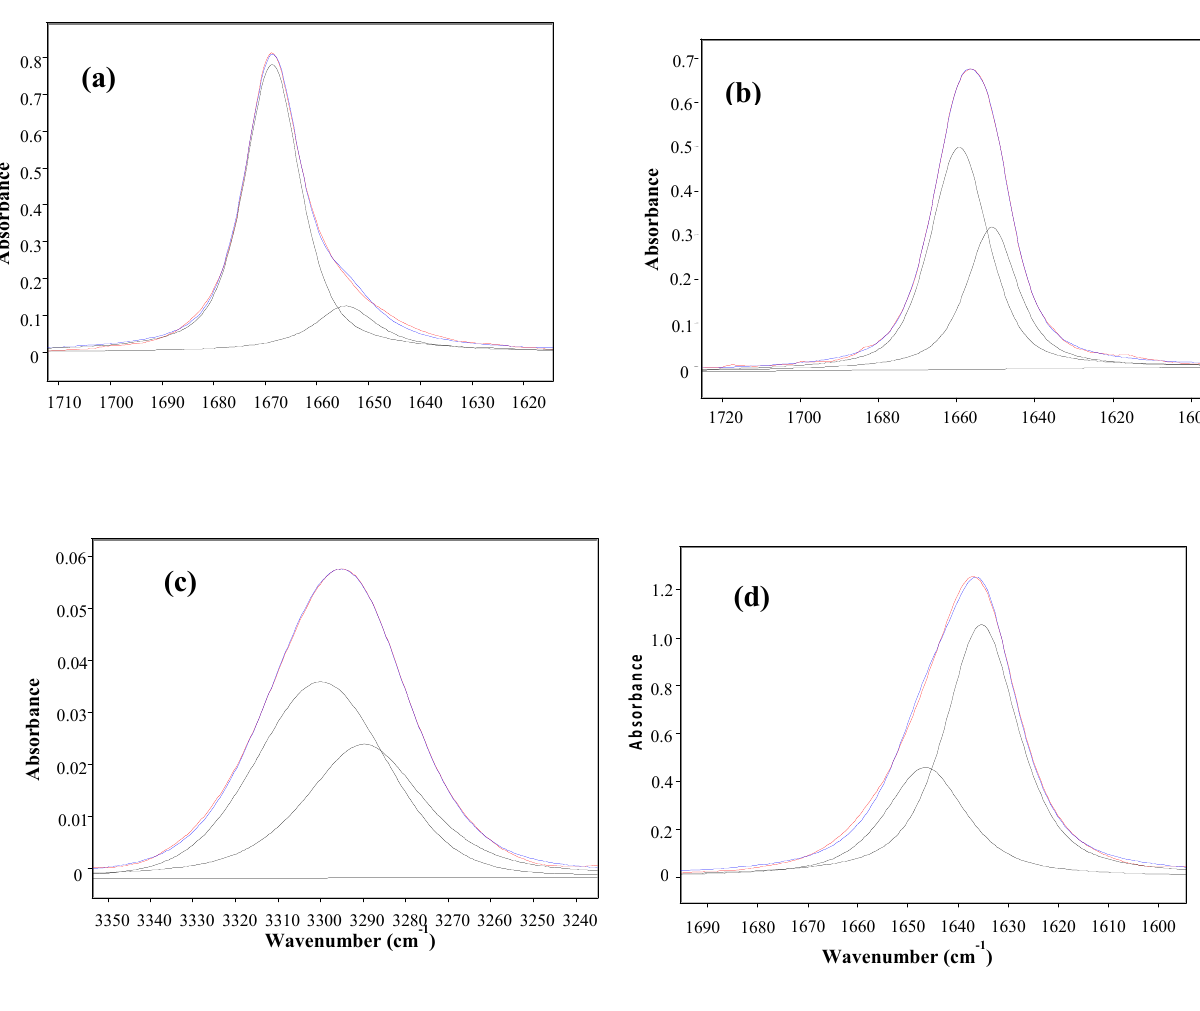
Figure 1. IR spectra of 3-(phenylsulfanyl)-1-methyl-2-piperidone ( 4 ) showing the analytically resolved carbonyl stretching band in: n -hexane ( a ), carbon tetrachloride [fundamental ( b ) and first overtone ( c )], chloroform ( d ) dichloromethane ( e ) and acetonitrile ( f